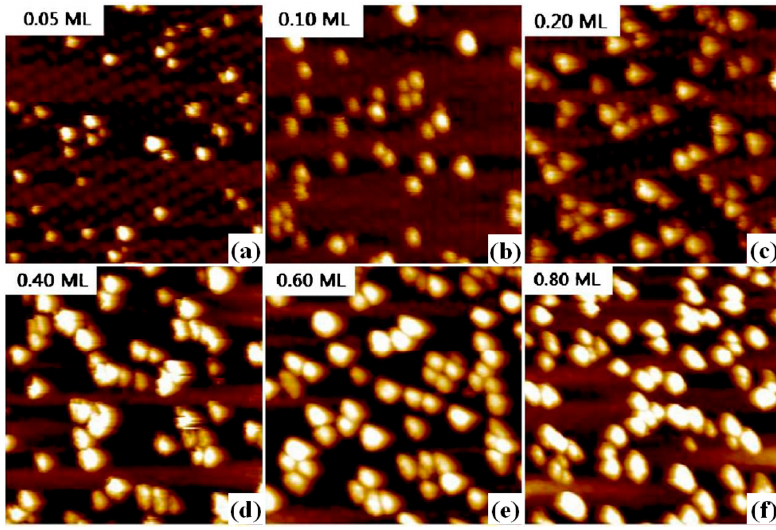
Figure 9. Scanning Tunneling Microscopy images (50 nm × 50 nm) of ( a ) 0.05 ML; ( b ) 0.1 ML; ( c ) 0.2 ML; ( d ) 0.4 ML; ( e ) 0.6 ML and ( f ) 0.8 ML Rh deposited on graphene/Ru(0001) at room